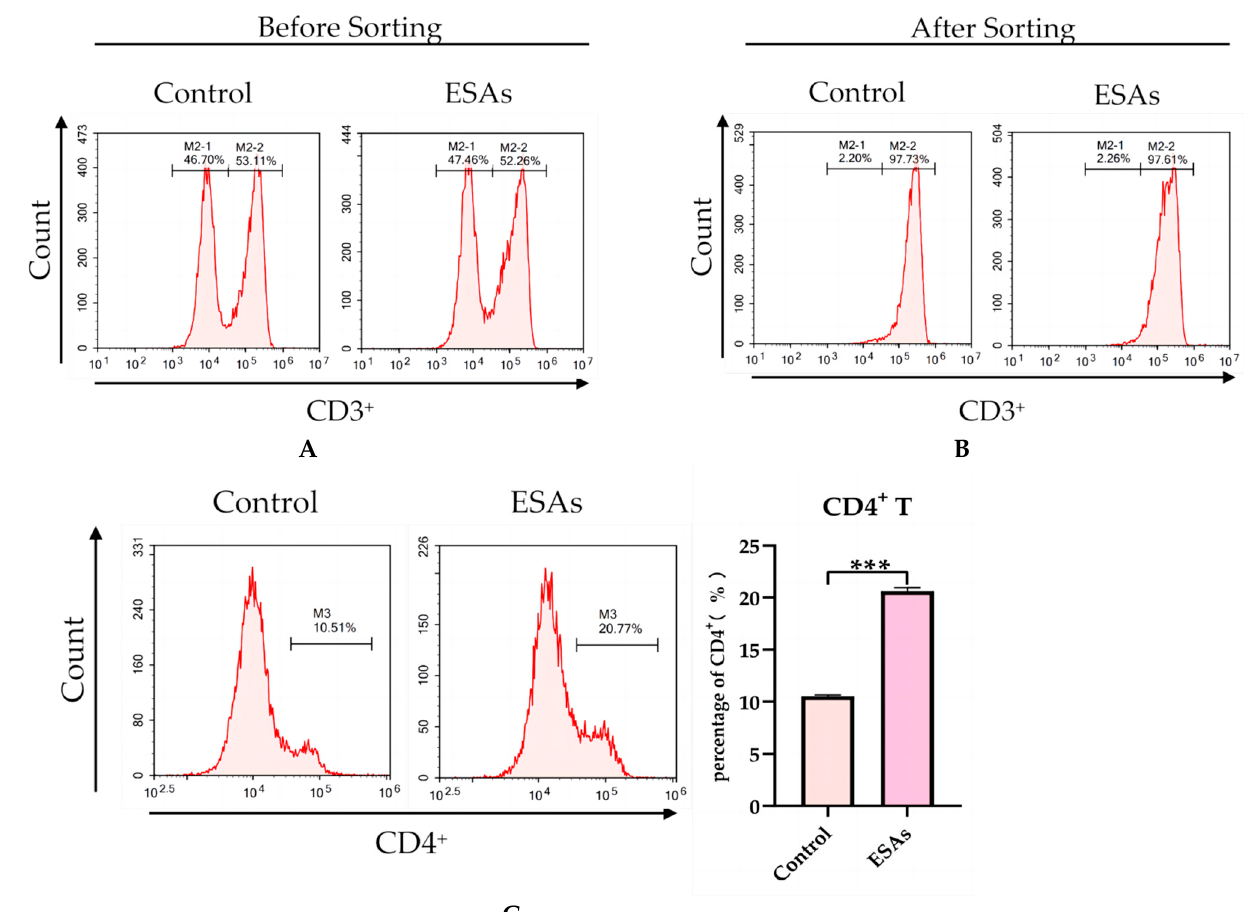
Figure 2. Analysis of the purity of CD3 + T cells and the ratio of CD4 + T cells. ( A ) The proportion of CD3 + T cells before magnetic bead sorting. ( B ) The proportion of CD3 + T cells after magnetic bead sorting. ( C ) Through flow cytometry analysis, the percentage of CD4 + T cells in the ESAs group was found to be significantly higher than that of the control group in terms of CD3 + T cells. *** P < 0.001.